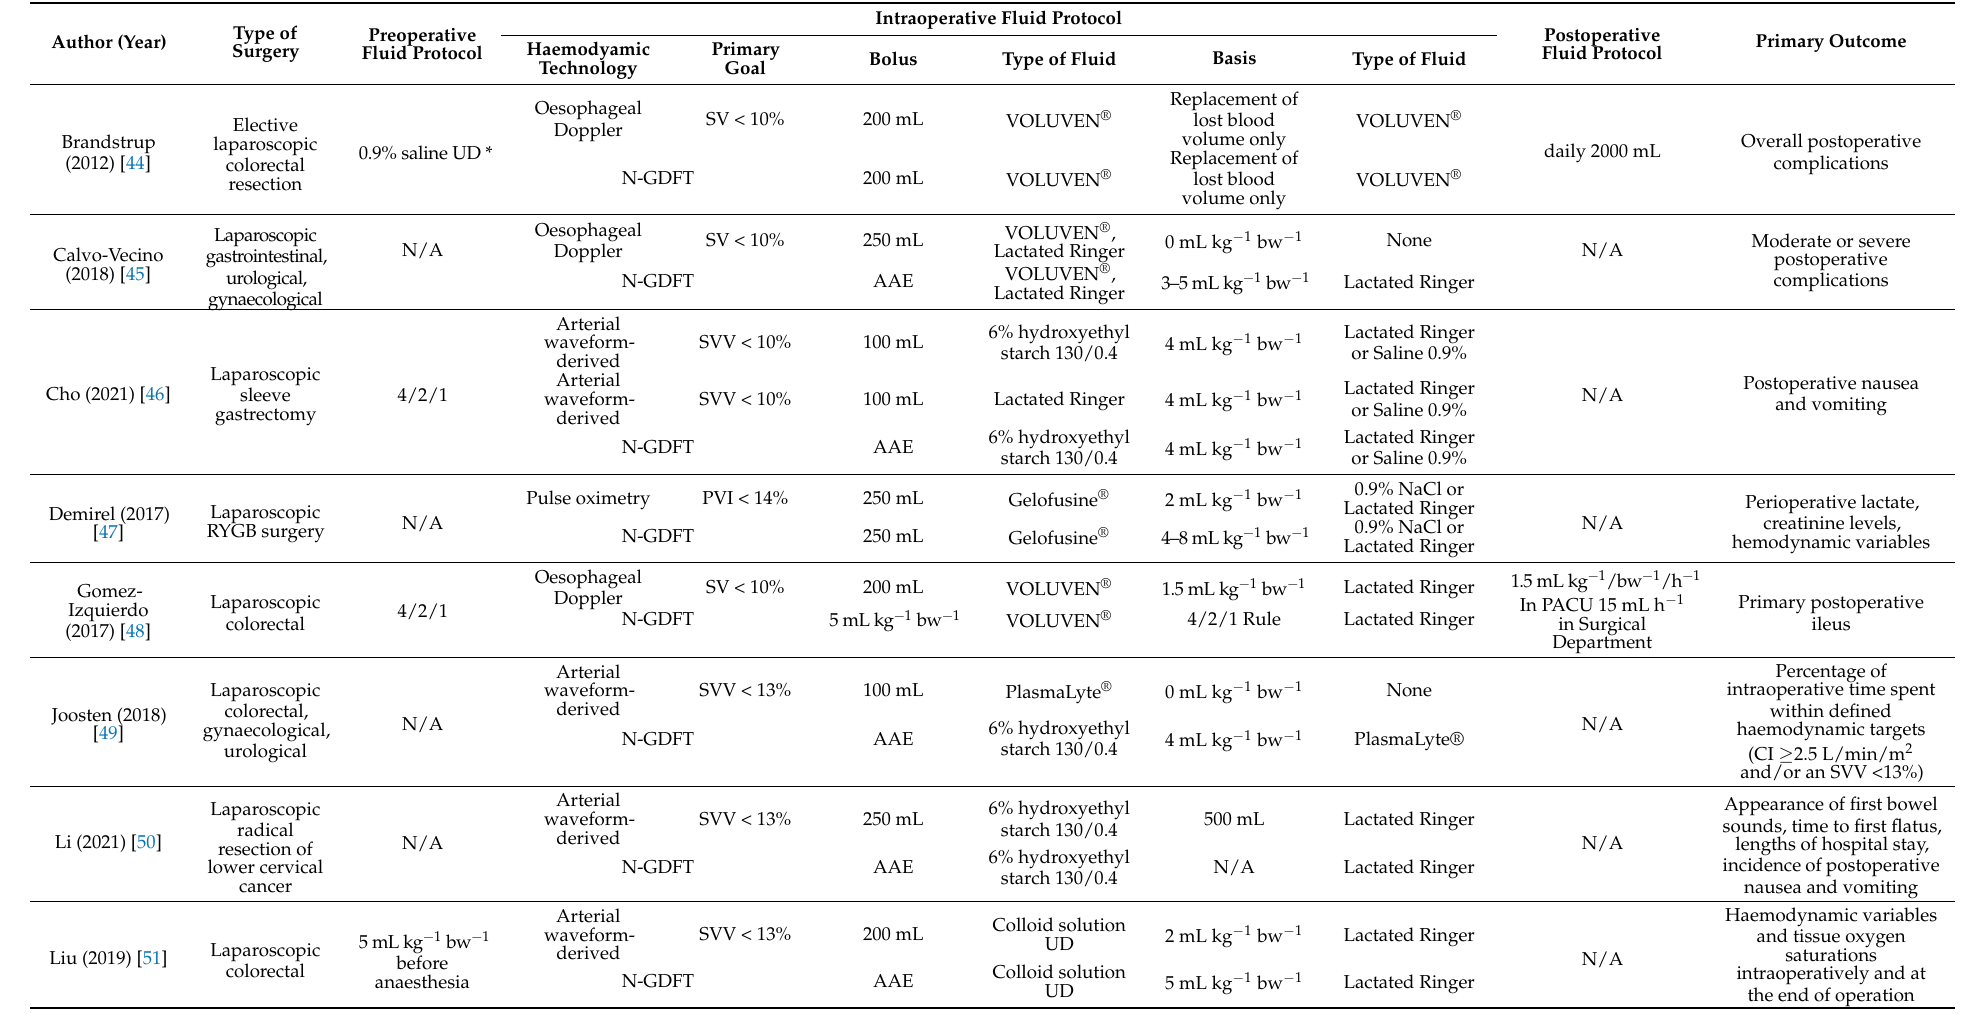
Table 1. Characteristics of included